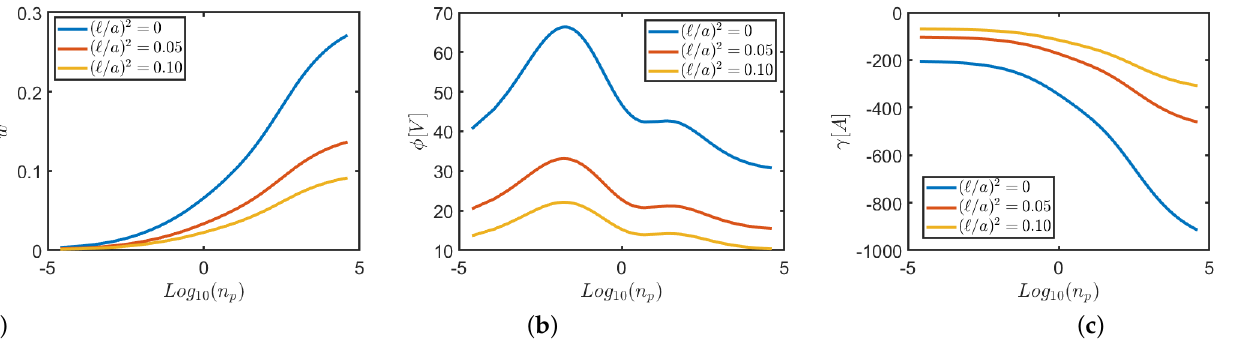
Figure 6. Graphs of displacement ¯ w (a) electric φ (b) and magnetic γ (c) potential, in the point ( a /2, b /2 ) to vary of n p and for different values of nonlocal parameter ( (cid:96) / a ) 2 and for n p = 1. (SDL; q = 0 N/m 2 , T 0 = T 1 = 0 K, ρ E = 0 C/m 2 , ρ H = 1 Wb/m 2